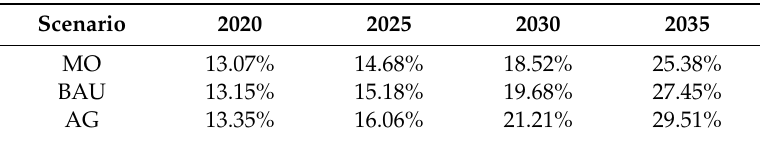
Table 12. Comparison of the RES share of the total electricity generation over the planning horizon under the MO, BAU, AG electricity marketization